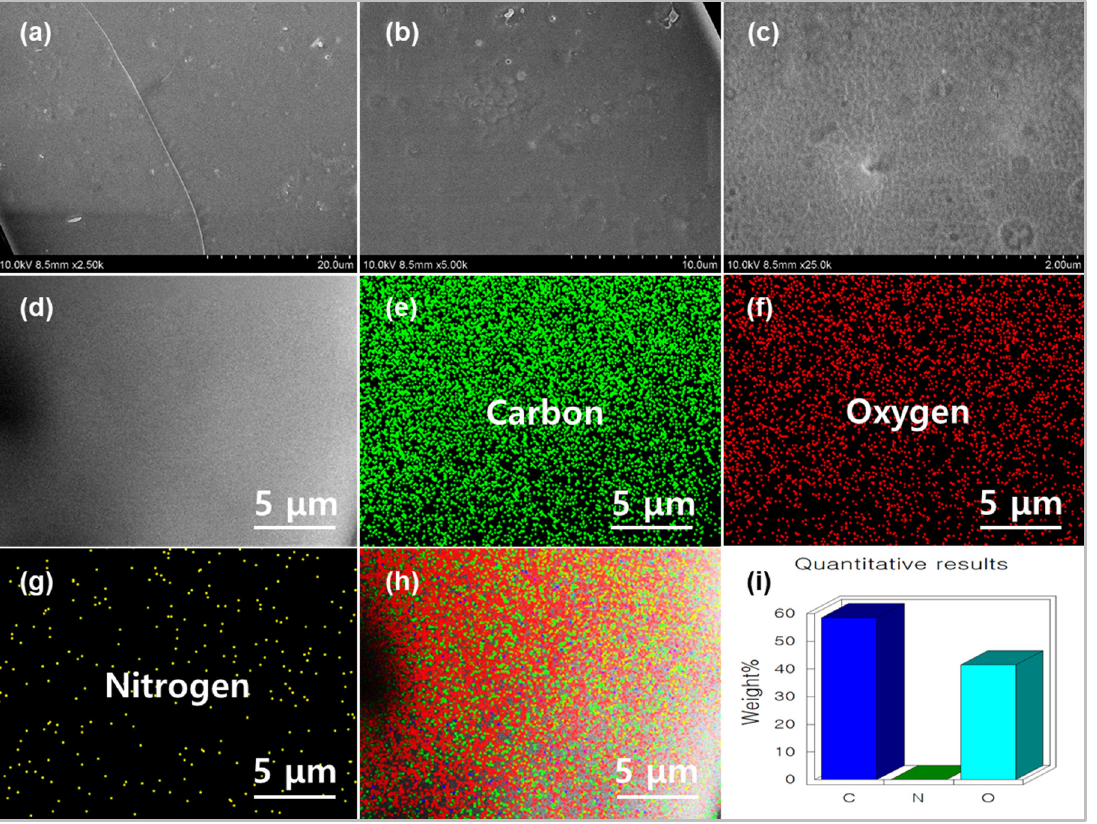
Figure 1. ( a – d ) FE-SEM images with different magnifications of prepared natural nitrogen-doped carbon dots. Elemental mapping of ( e ) carbon, ( f ) oxygen, ( g ) nitrogen, and ( h ) overlapping of all the elements of prepared natural nitrogen-doped carbon dots. ( i ) Quantitative results of presented elements in the prepared natural nitrogen-doped carbon